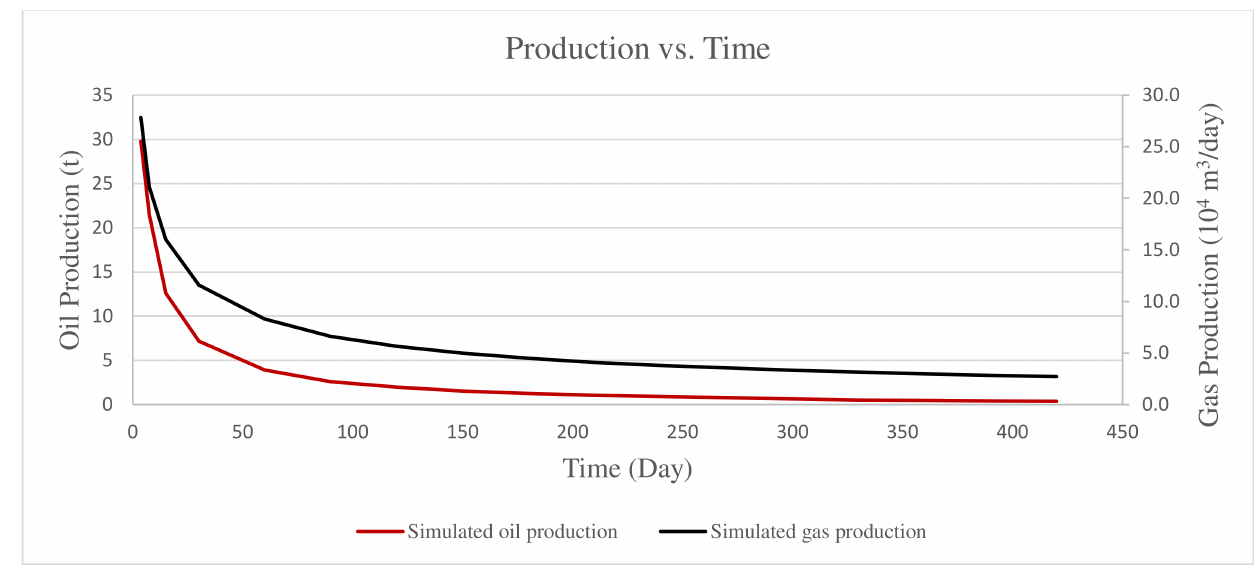
Figure 16. Plot of gas production data with time of the tilt-up well example.